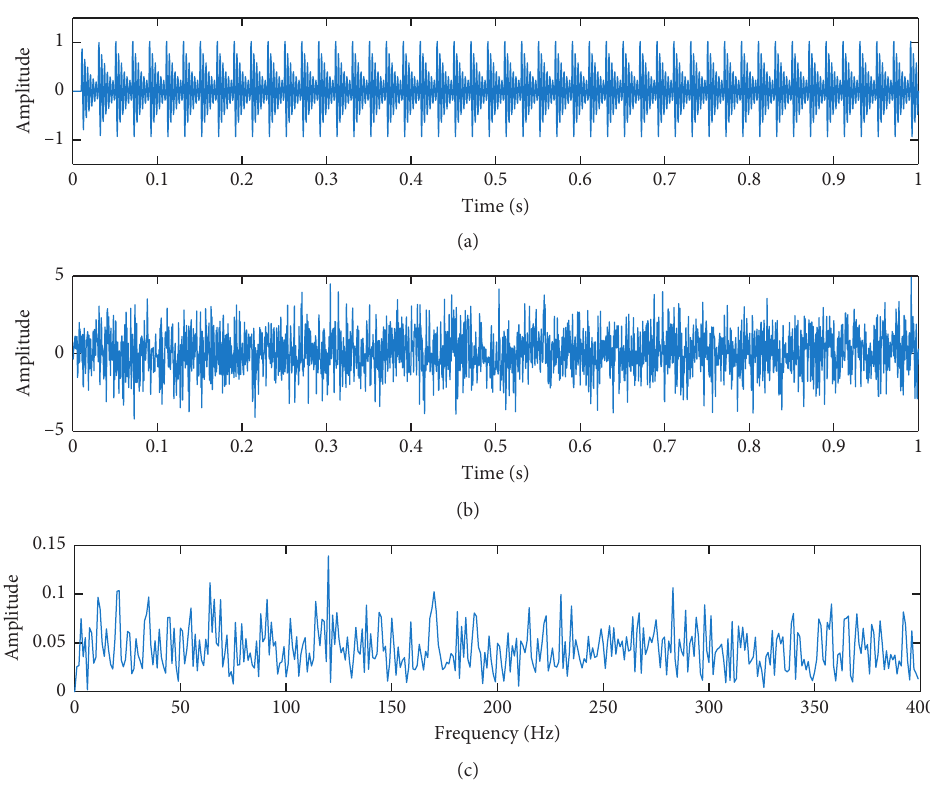
Figure 6: The wave of simulated signal (SNR � − 10 dB): (a) pure signal x ( t ) , (b) noisy signal y ( t ) , (c) envelope